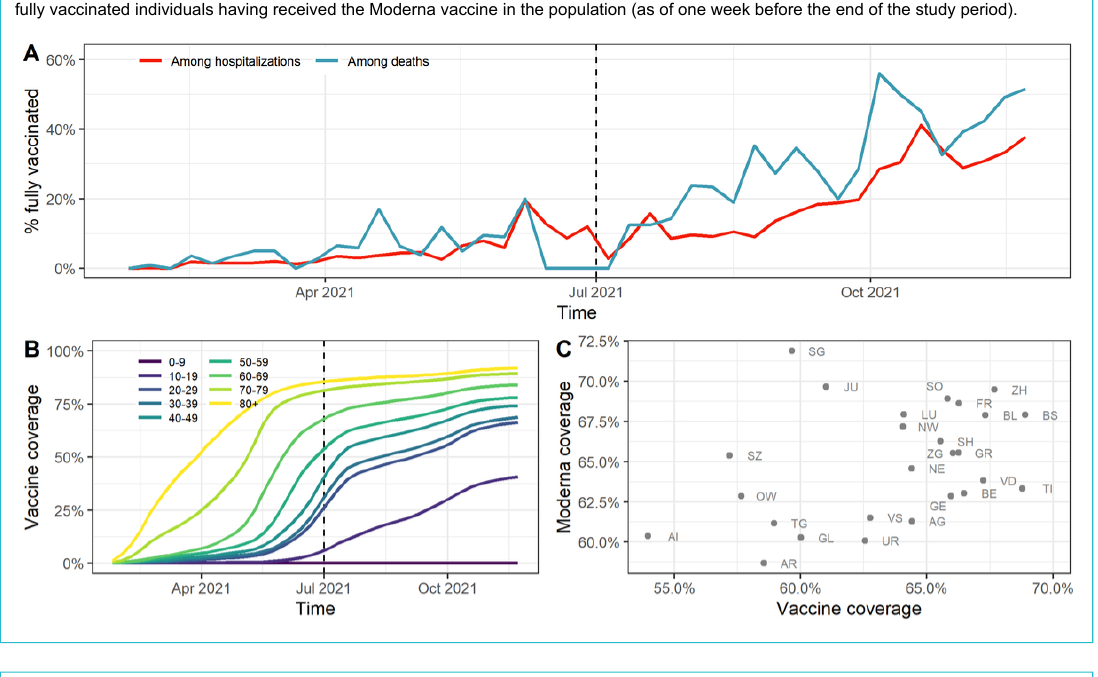
Figure 3: Change in the relative risk (RR9 of COVID-19-related hospitalisation depending on the time since vaccination in weeks (reference is 0–12 weeks), overall (panel A), by age group (panel B) and by vaccine type (panel C). Numbers correspond to group sizes (n), analysis for vaccine type (panel C) is based on fewer observations, as people with unknown vaccine type (n = 120, 19%) were